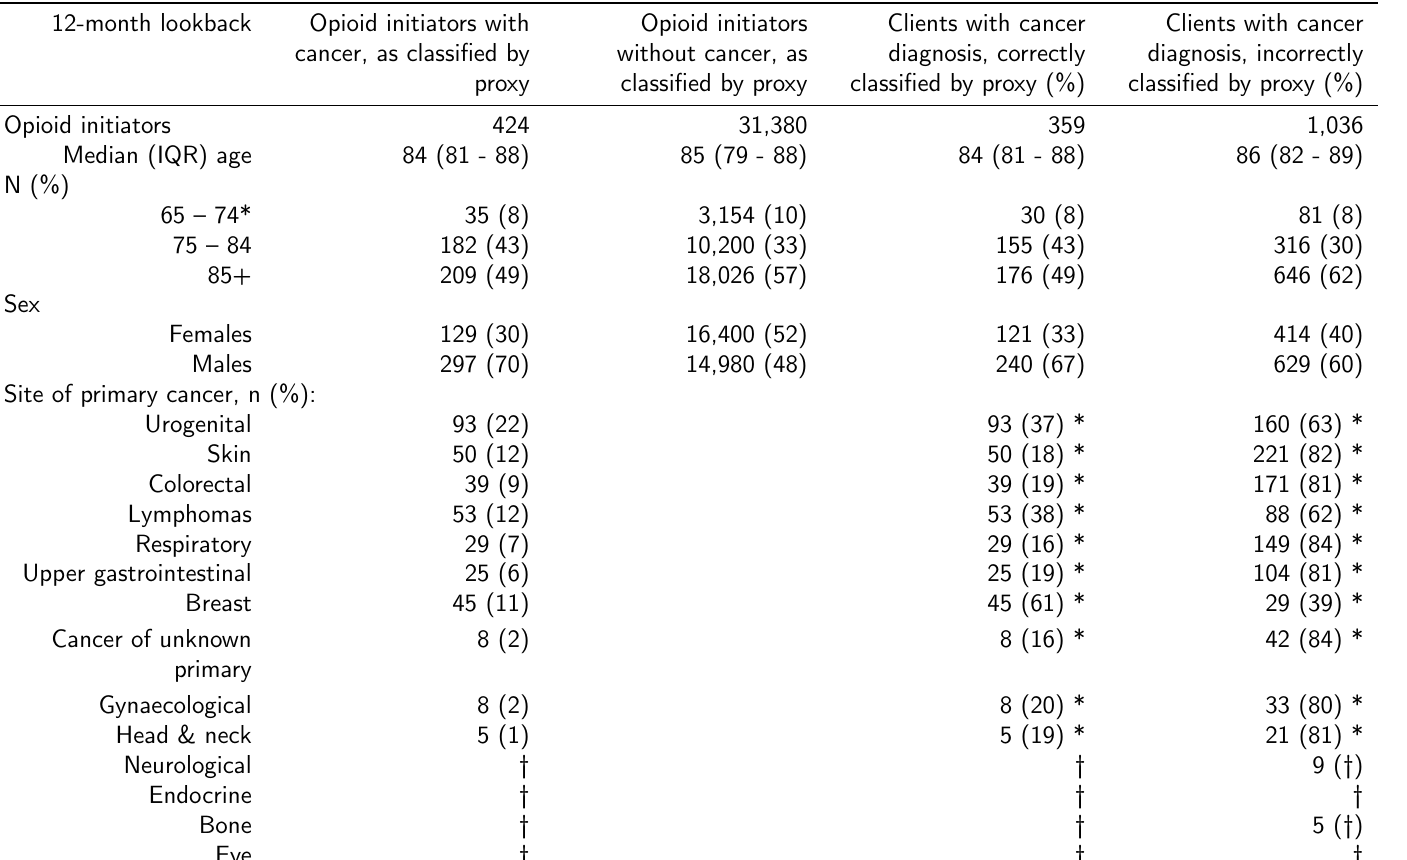
Clients with cancer diagnosis, incorrectly classified by proxy (%) classified by proxy (%)